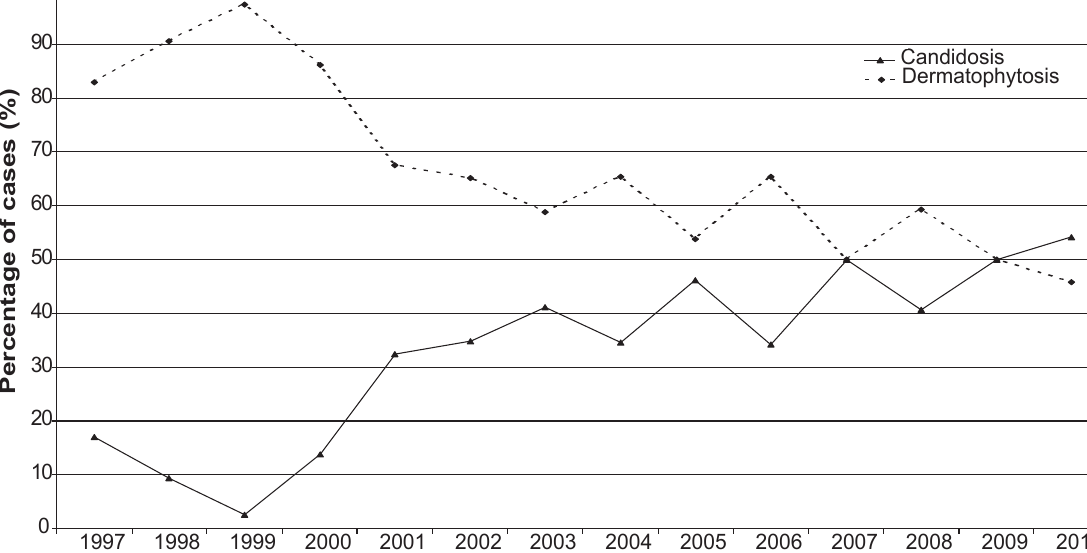
Figure 1 Frequency of dermatophytosis and candidosis during the period